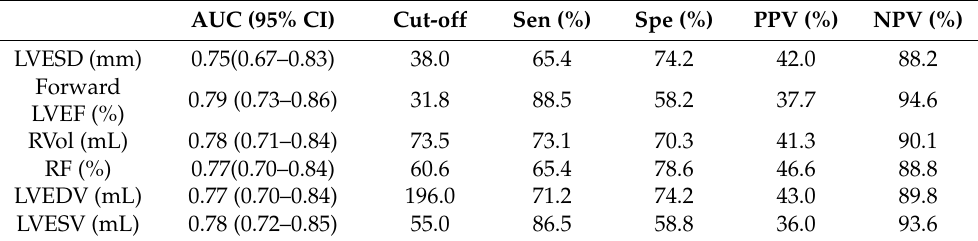
LVD = left ventricular dysfunction; MVr = mitral valve repair; AUC = area under curve; CI = confidence interval; Sen = sensitivity; Spe = specificity; PPV = positive predictive value; NPV = negative predictive value; LVESD = left ventricular end-systolic diameter; LVEF = left ventricular ejection fraction; RVol = regurgitant volume of mitral regurgitation; RF = regurgitant fraction of mitral regurgitation; LVEDV = left ventricular end-diastolic volume; LVESV = left ventricular end-systolic volume.